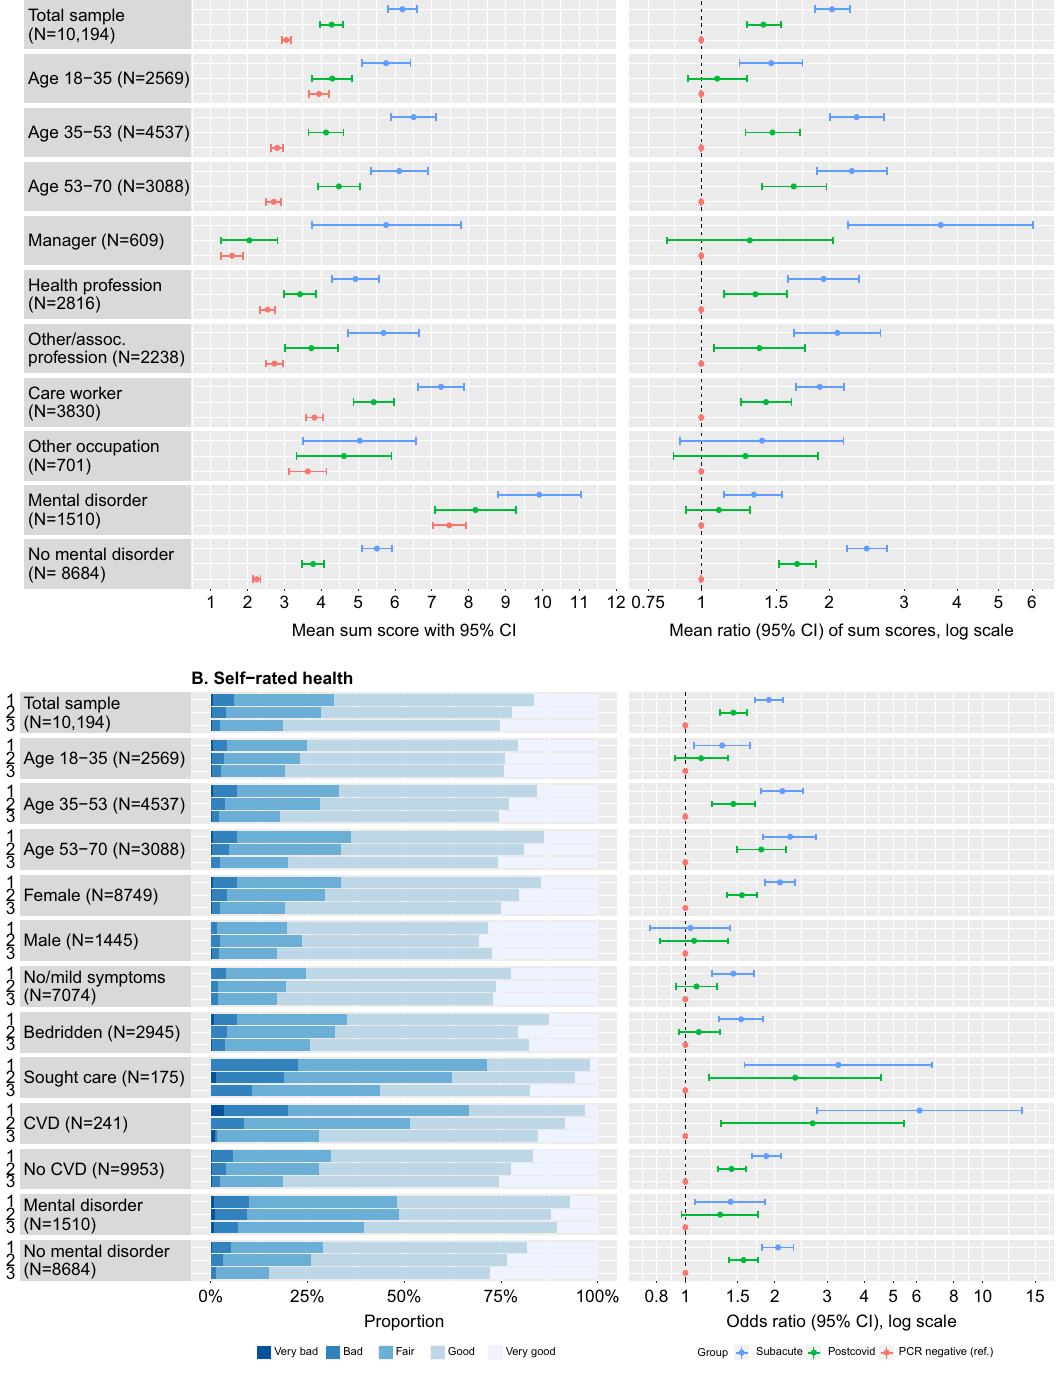
Group: 1. Subacute 2. Postcovid 3. PCR negative Figure 4. Distribution of WHODAS 2.0 score and rating of self-rated health between subgroups. ( A ) Mean WHODAS 2.0 scores with 95% confidence intervals (left panel) and mean ratio of WHODAS 2.0 scores (right panel, estimated from univariable negative binomial regression analyses) in subgroups where there was a significant interaction between the variable of interest and COVID-19 status on the effect of WHODAS 2.0. ( B ) Proportions of ratings of self-rated health (left panel) and odds ratios for worse self-rated health (right panel, estimated with univariable ordinal logistic regression) in subgroups where there was a significant interaction between the variable of interest and COVID-19 status on the effect of self-rated